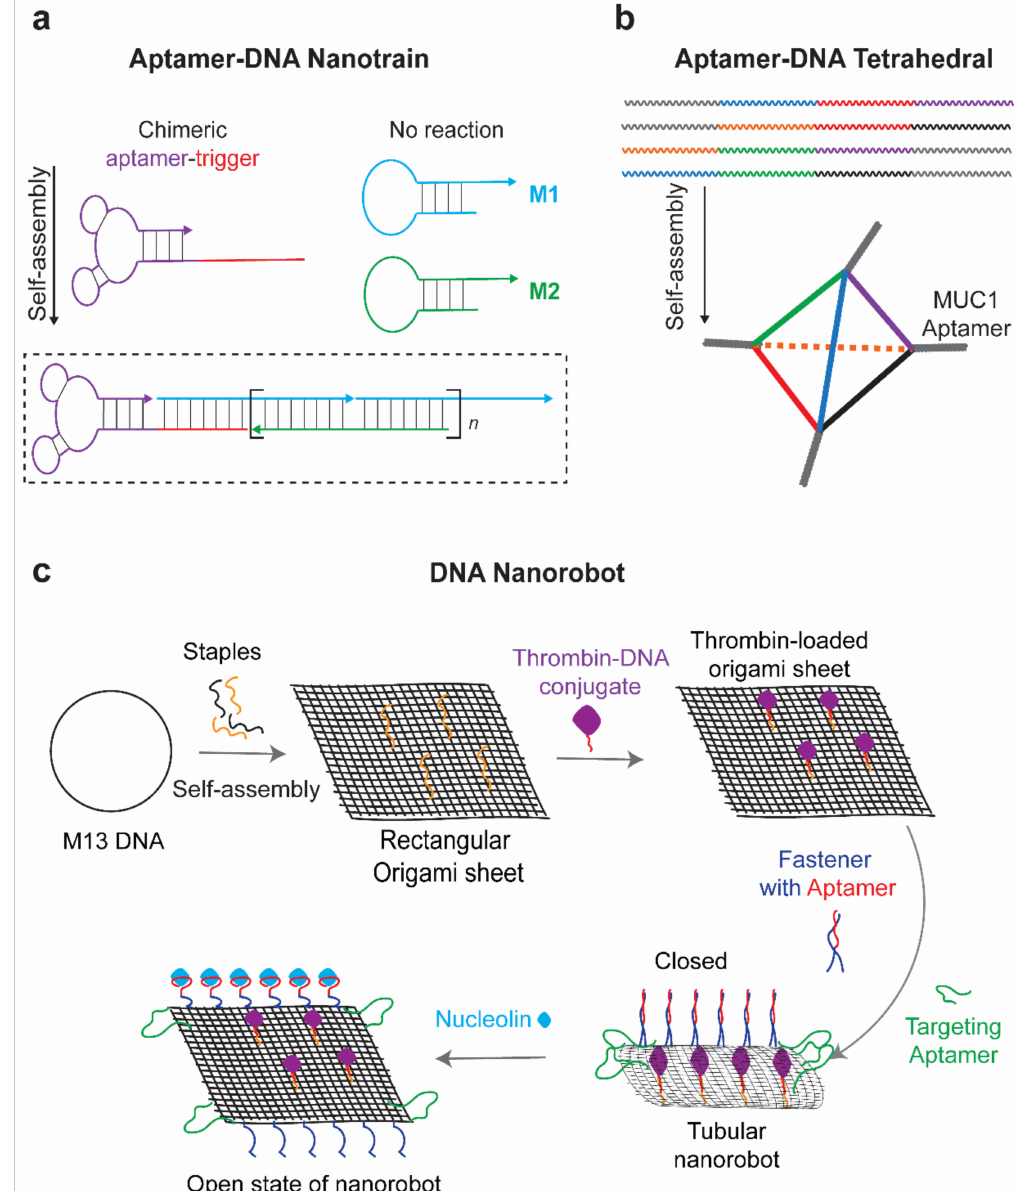
Figure 3. Schematic representation of DNA nanostructure assembly. ( a ) DNA nanotrain with aptamers assembled via complementary sequence. Modified with permission from reference [64]. Copyright 2013 PNAS. ( b ) Assembly of DNA tetrahedron through simple extension of strands. Modified with permission from reference [65]. Copyright 2019 RSC publishing. ( c ) Aptamer guided and gated the delivery of therapeutic drugs. Adapted from reference [66]. Copyright 2017 ACS